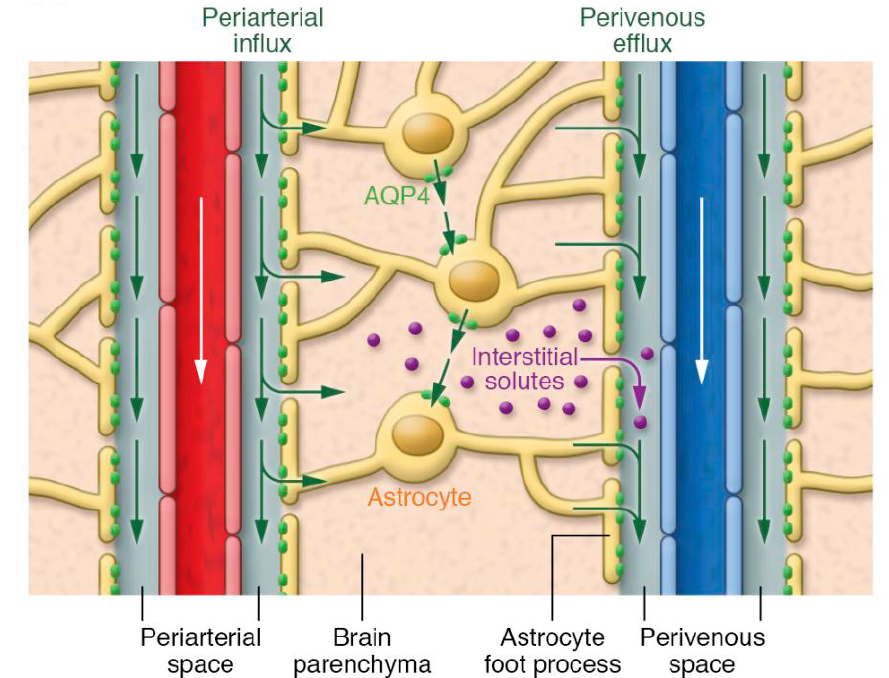
Figure 1. Schematic outline of the brain glymphatic pathway. CSF flows into the brain parenchyma from periarterial channels, and exchanges with ISF in a process facilitated by AQP4 water channels. These channels are densely present at the astrocytic vascular endfeet that create an outer wall around the cerebral vasculature. The CSF/ISF mixture subsequently exits the brain parenchyma along perivenous pathways. The blood flow direction is indicated with white arrows. Green arrows indicate the movement of CSF and ISF. Purple dots indicate interstitial solutes [9] Note. Adapted from “Understanding the functions and relationships of the glymphatic system and meningeal lymphatics,” by Louveau A, Plog BA, Antila S, Alitalo K, Nedergaard M, Kipnis J. J Clin Invest. 2017;127:3210–9 (https://www.jci.org/articles/ view/90603). © 2017 American Society for Clinical